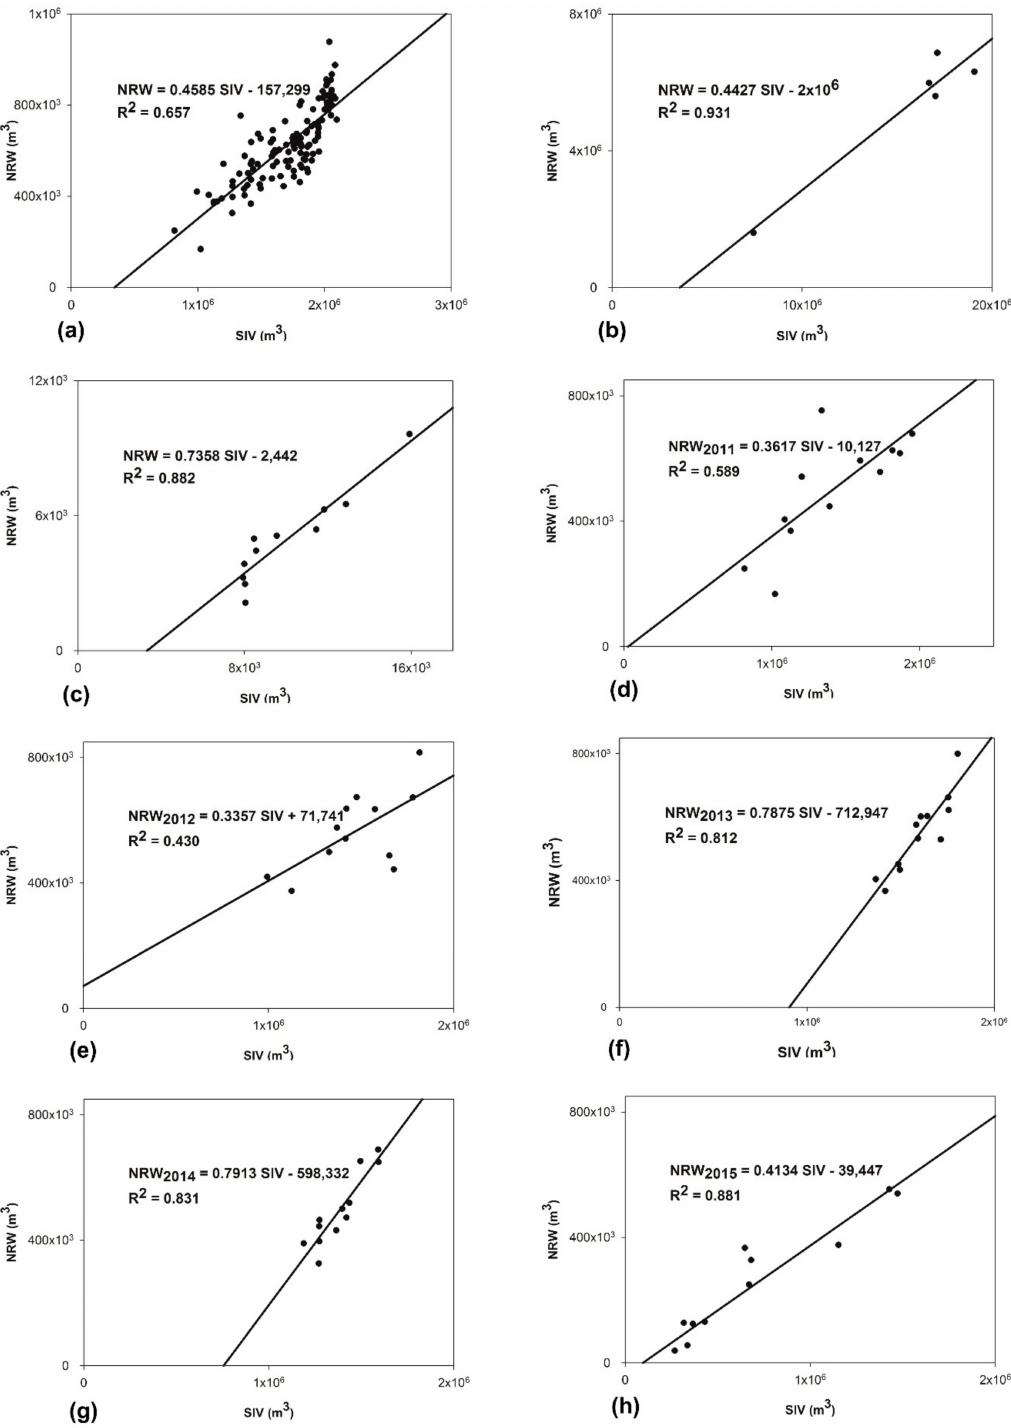
Figure 5. NRW–SIV regression equations; ( a ) monthly volumes for 2005–2015; ( b ) annual volumes for 2011–2015; ( c ) monthly volumes for a DMA in Sana’a; and ( d )–( h ) monthly volumes for 2011, 2012, 2013, 2014 and 2015,